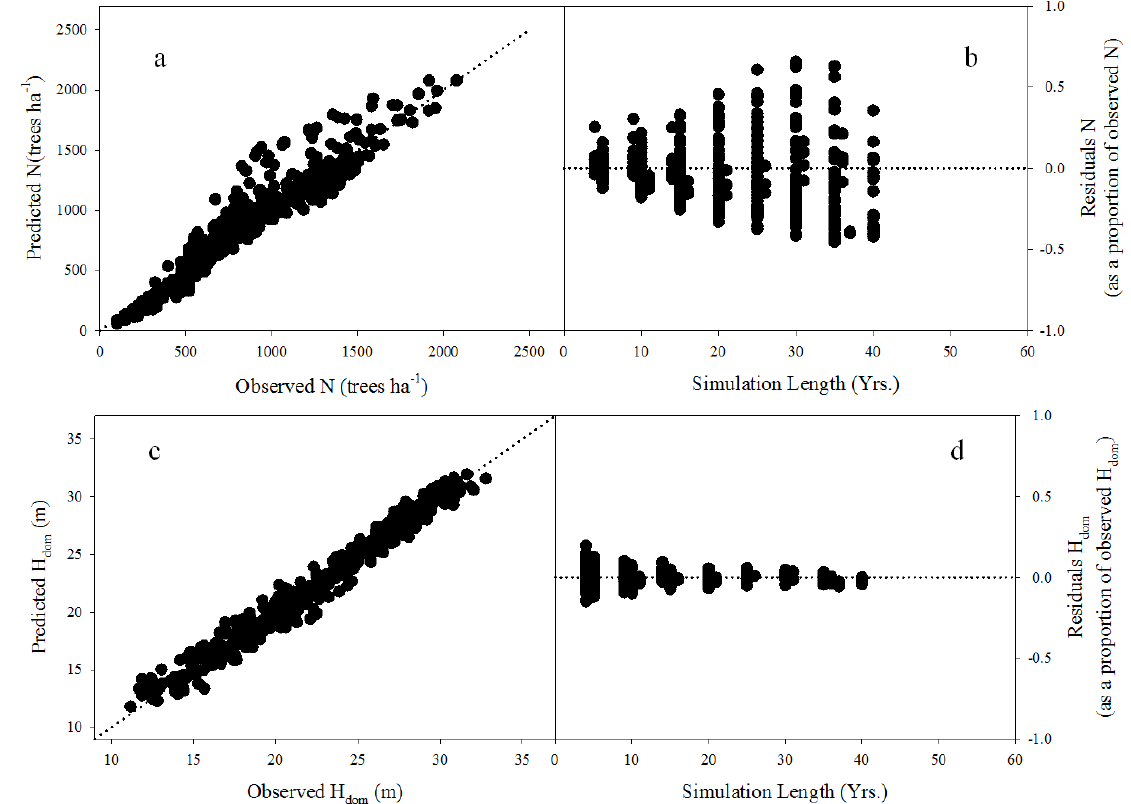
Figure 6. Overall simulation validation of survival (N) ( a , b ), dominant height (H basal area (BA) ( e , f ) and stem volume outside bark (VOL versus predicted (simulated) values ( a , c , e , g ) and residuals (predicted-observed) versus simulation length (yrs.) ( b , d , f , h ) relationships for unthinned stands if initial age, N and SI are known, using the models to estimate N, H in the dataset based only on knowing the initial stand age, N and